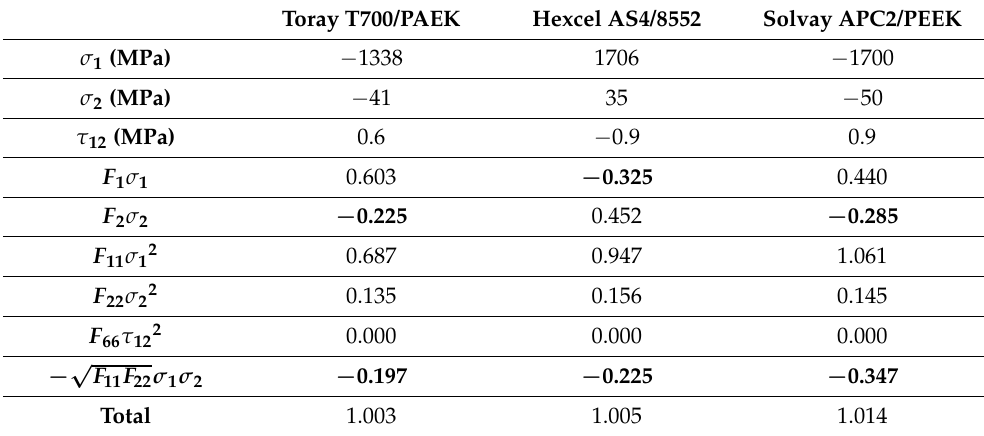
Table 6. Tsai–Wu index components for three analyzed systems. Bold terms contribute to the enhanced load-bearing capacity of the systems.